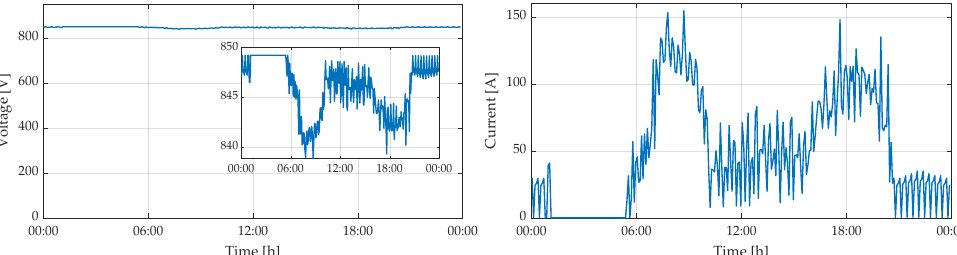
Figure 22. Weight-based simulation results of voltage ( left ) and current ( right ) in TS M in an average window of 5 min. The plots cover a 24-h simulation